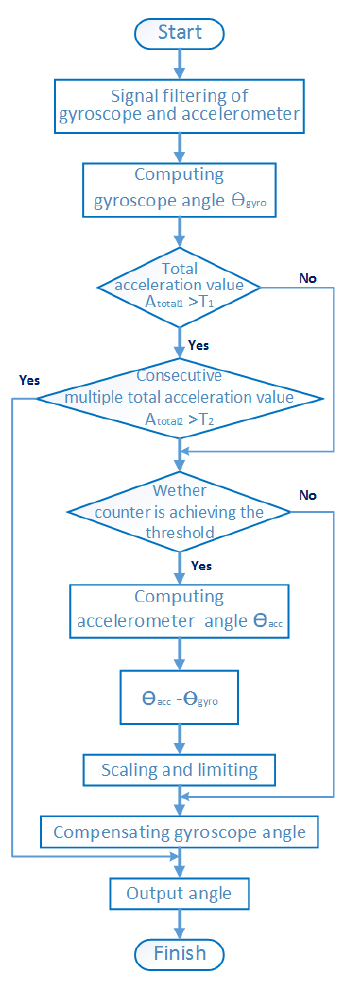
Figure 4. Accelerometer compensation